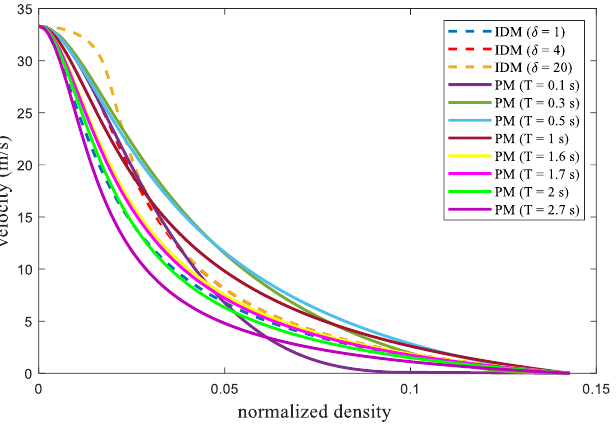
Figure 4. Velocity behaviour of the ID and proposed models over a circular road of length 800 m. Table 3. Maximum flow, maximum density, and critical velocity for the ID model. Table 4. Maximum flow, maximum density, and critical velocity for the proposed model. Maximum Flow Acceleration Exponent 𝜹 Maximum Density Maximum Flow Critical (veh/s) Time Headway T (s) Maximum Density (veh/s)